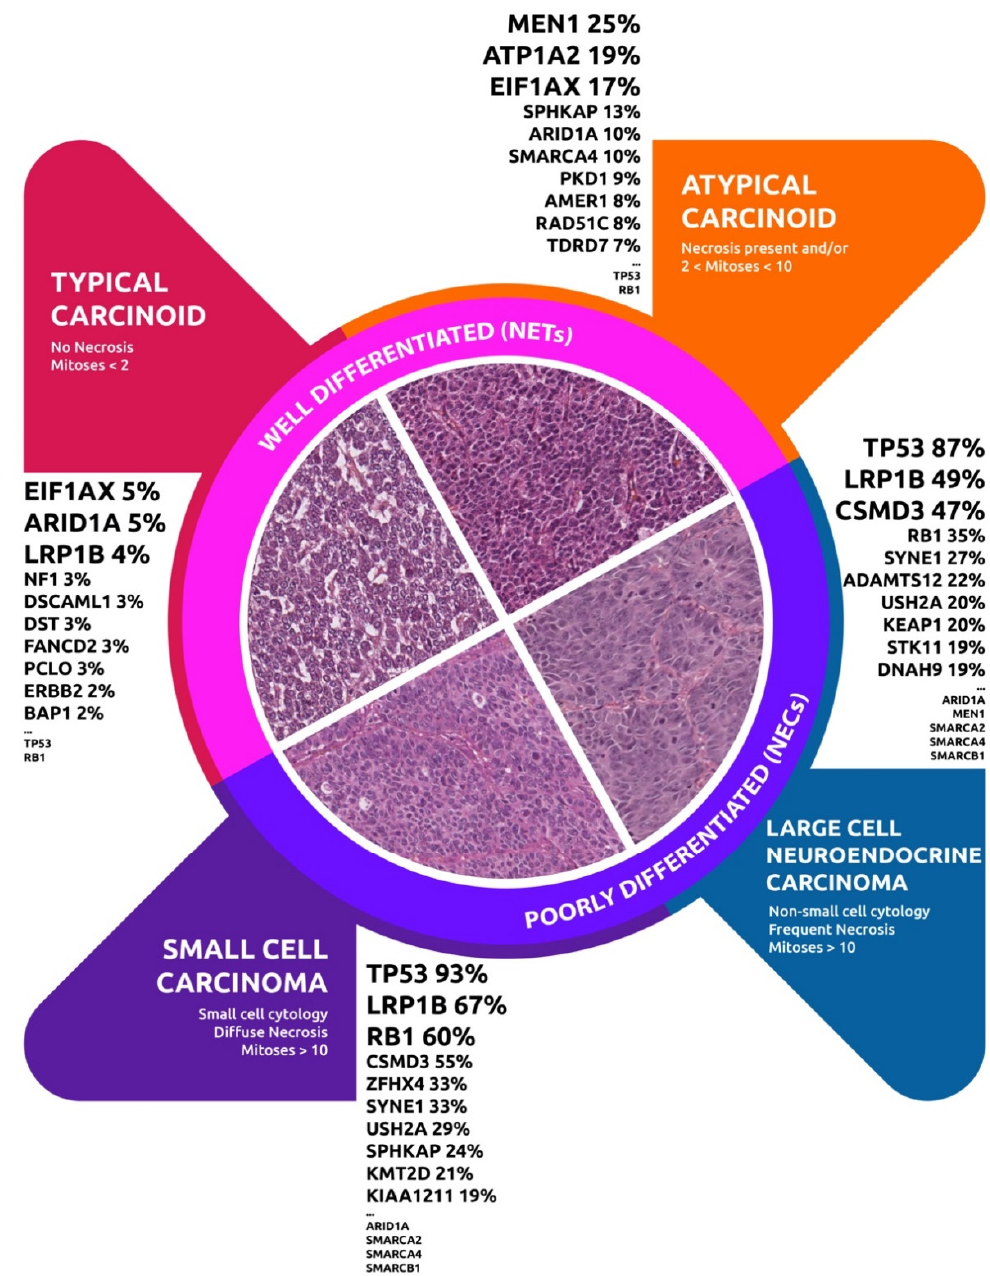
Figure 4. Genomic alterations among the LNENS World Health Organization 2015 groups.